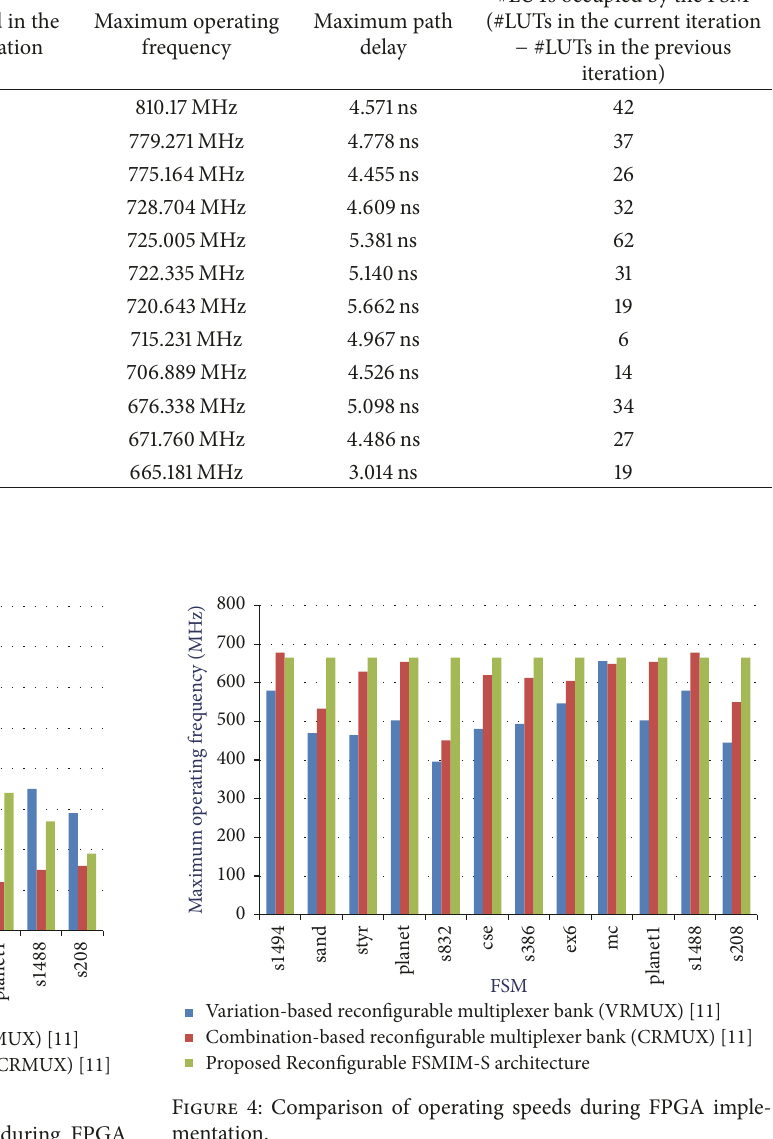
Figure 3: Comparison of hardware requirements during FPGA implementation.